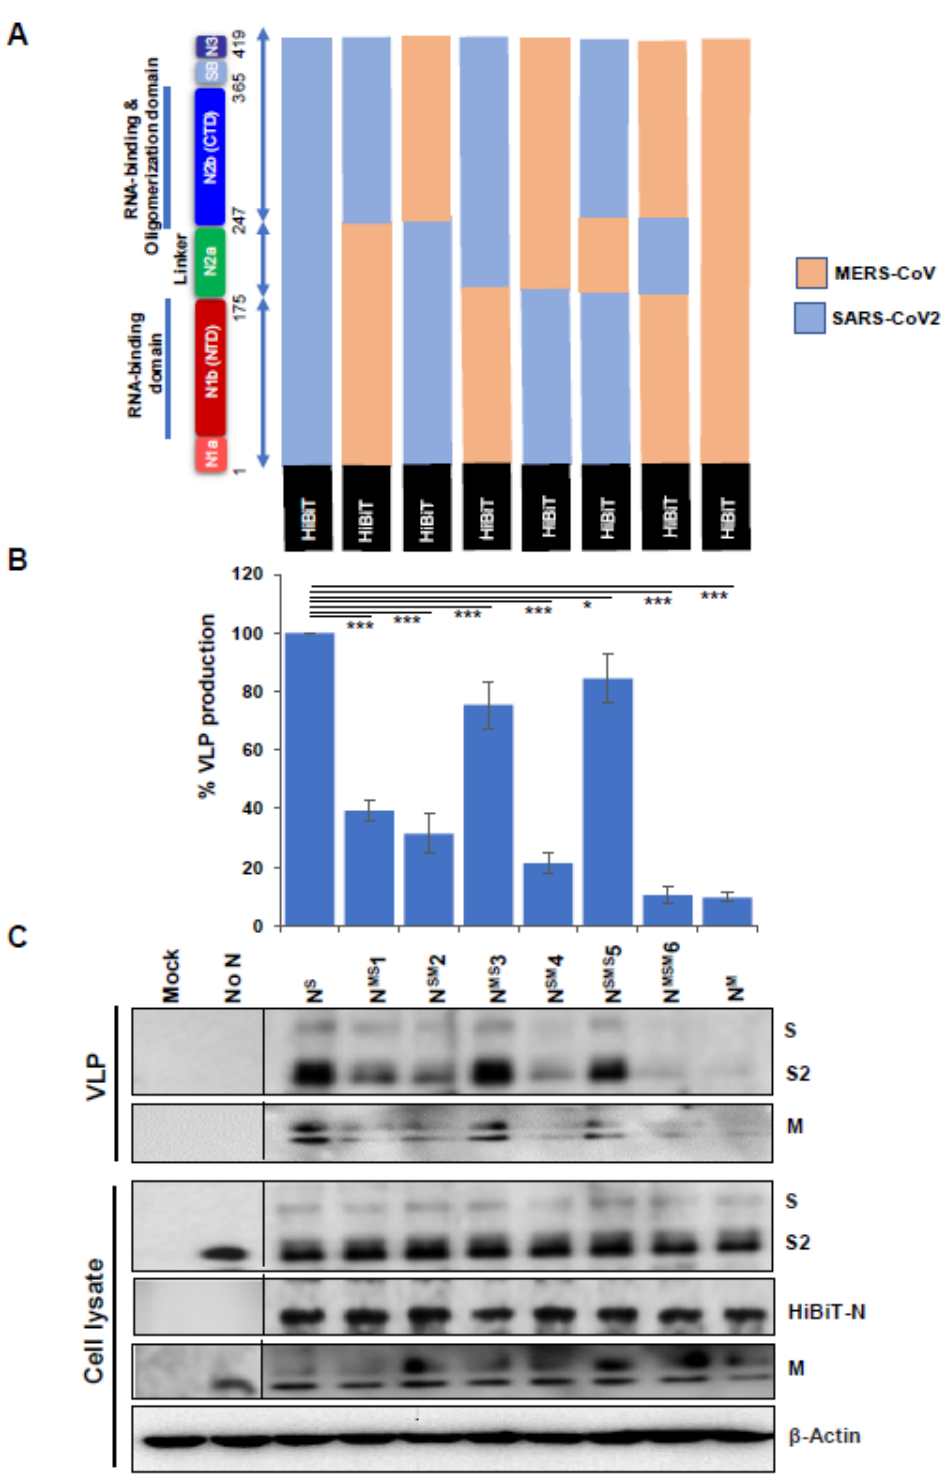
Figure 4. N protein CTDs facilitate VLP production. ( A ) Schematic diagram depicting SARS-CoV2/MERS-CoV N protein chimeras. Domains derived from SARS-CoV2 N proteins are in blue, with superscripts “S” and domains derived from MERS-CoV N proteins are in brown, with superscripts “M”. All chimeric N proteins are HiBiT-tagged. ( B ) HiBiT-N plasmids were co-transfected with SARS-CoV2 S, M, and E to produce VLPs. Yields of SEC-purified VLPs were determined by LgBiT complementation (NanoBiT technology). Results are means ± SE of three independent experiments. * p < 0.05, *** p < 0.001. ( C ) S, M, and N proteins in purified VLPs and cell lysates were detected by WB methods. Dotted lines separate blots obtained from separate